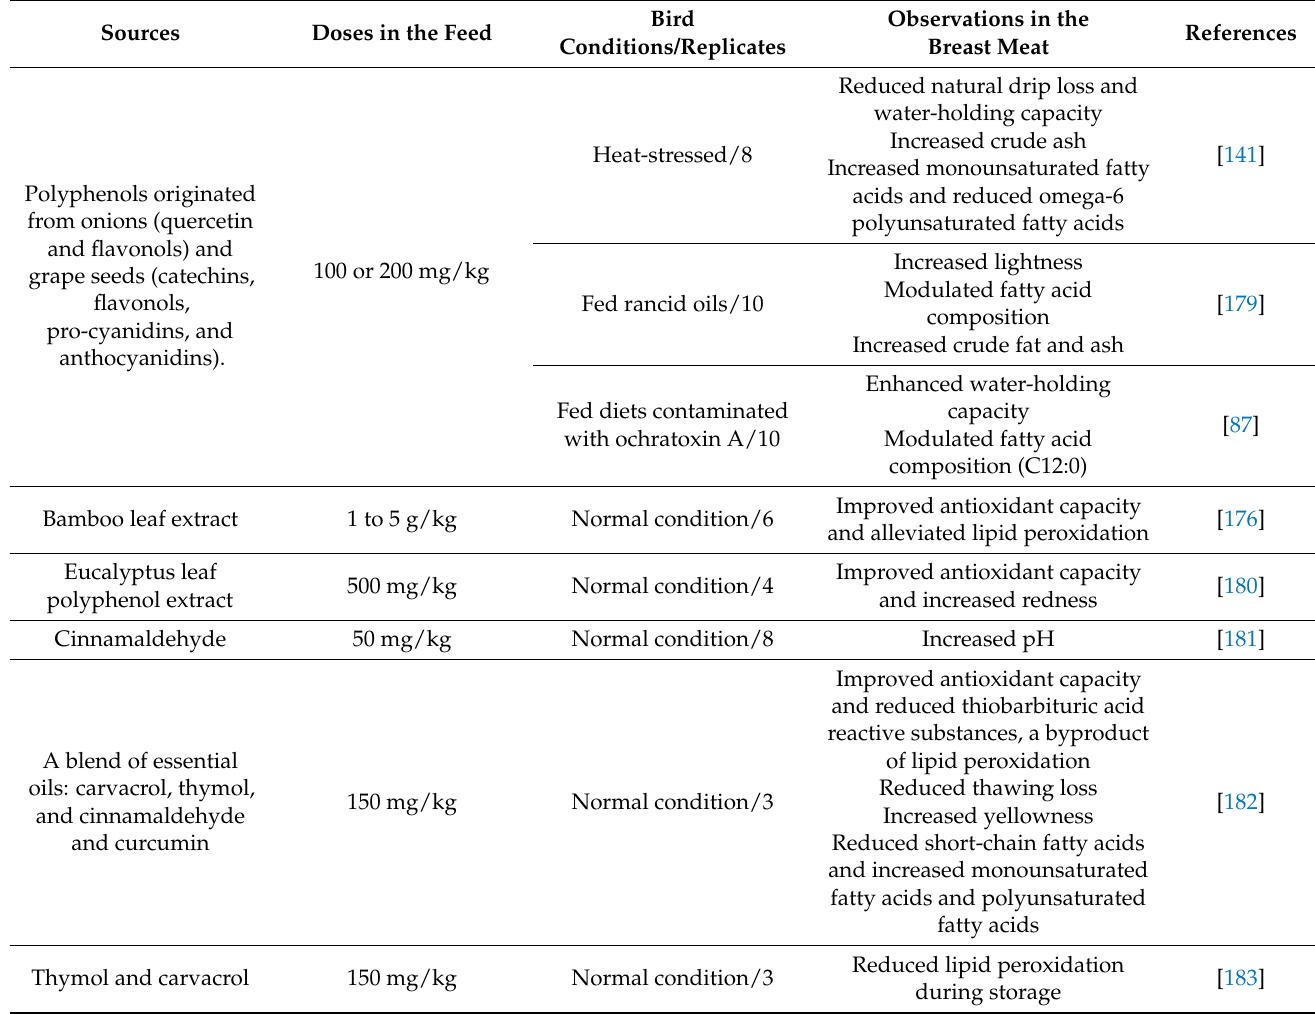
Figure 2. Proposed modes of action of polyphenols depending on their molecular weight and absorption rate in the gastrointestinal tract. Table 6. Effects of the supplementation of plant polyphenolic compounds (e.g., plant extracts and essential oils) on the meat quality of broiler chickens under different raising